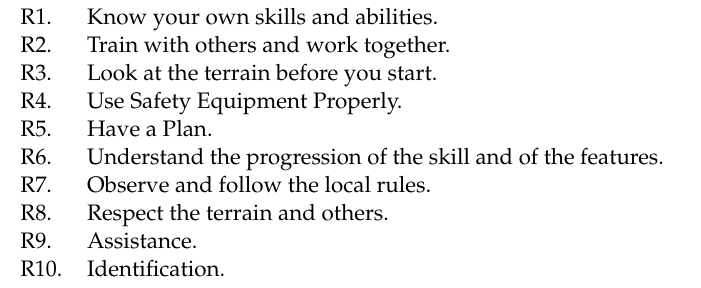
Table 1. The rules of the International Ski Federation (FIS) Code of Conduct for Snow Parks. R1. Know your own skills and abilities. R2. Train with others and work together. R3. Look at the terrain before you start. R4. Use Safety Equipment Properly. R5. Have a Plan. R6. Understand the progression of the skill and of the features. R7. Observe and follow the local rules. R8. Respect the terrain and others.